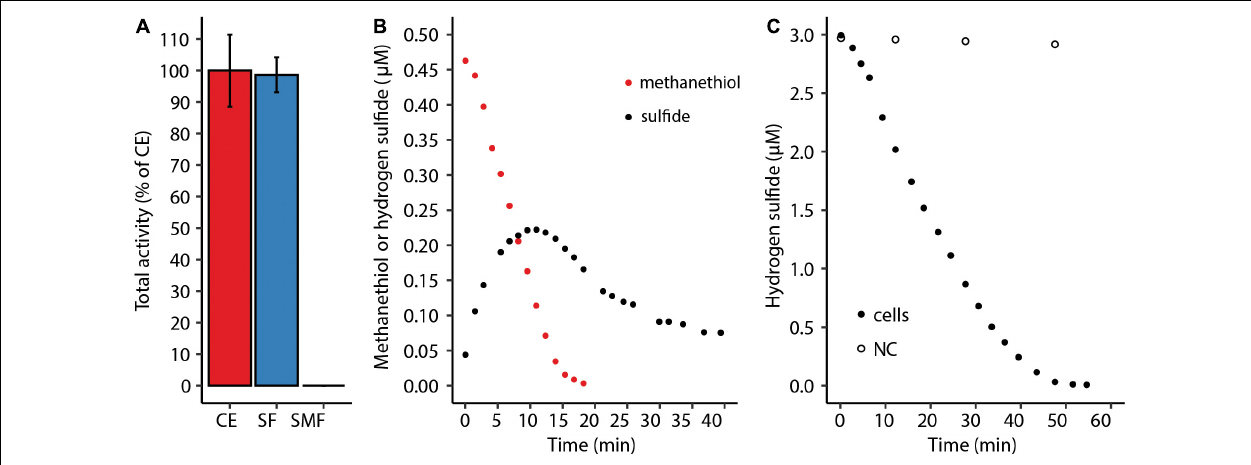
FIGURE 4 | (A) Total methanethiol-degrading activity of the soluble fraction (SF) and the solubilized membrane fraction (SMF) as percentage of the total activity of the crude extract (CE). Error bars indicate standard deviations ( n = 2). (B) Methanethiol consumption and H 2 S production by crude extract of Methylacidiphilum fumariolicum SolV. (C) Consumption of 3 µ M H 2 S by M. fumariolicum SolV cells in a serum bottle over time. NC, negative control with medium